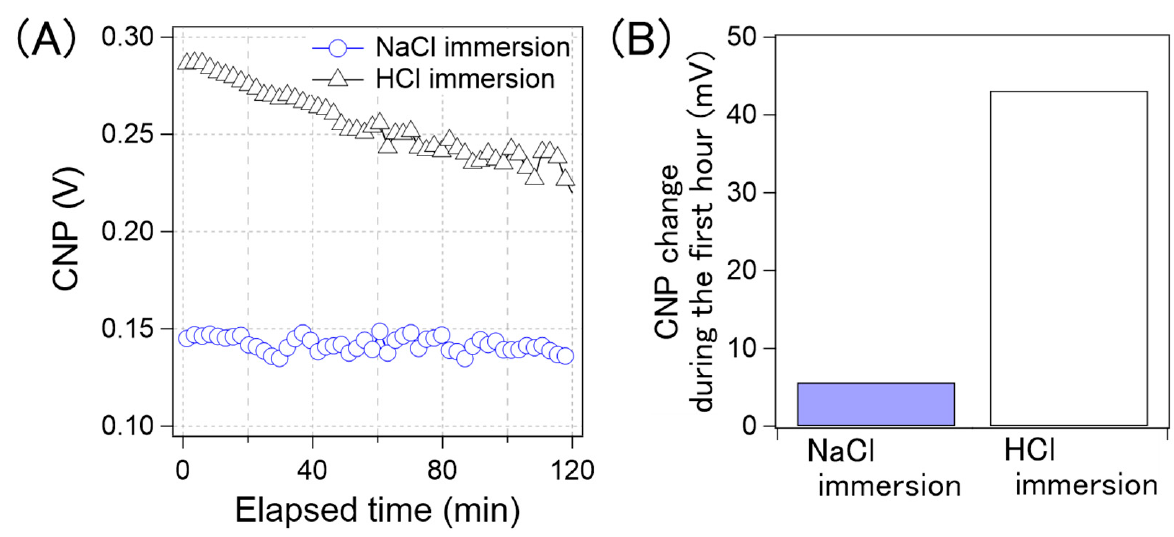
Figure 10. ( A ) Time-course of the CNP average of GFETs with NaCl immersing (blue circle) and with HCl immersing (black triangle). ( B ) the CNP shift amount of the GFETs with NaCl immersion and with HCl immersion during the first hour.